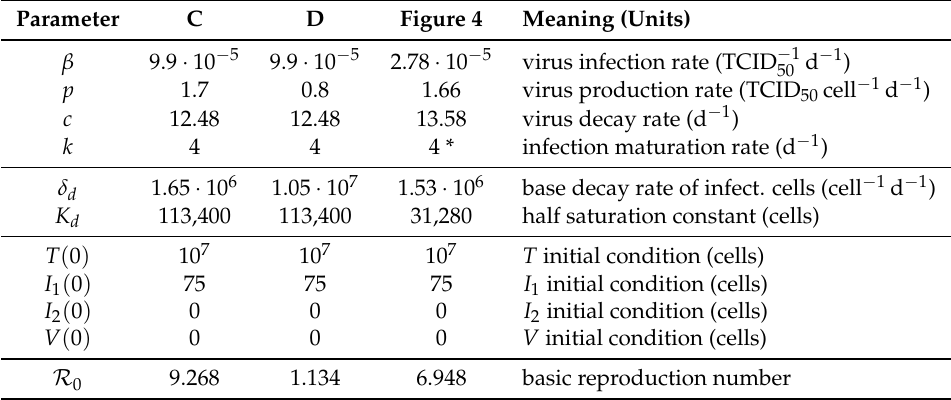
Table 2. Parameters of the target model (9) corresponding to data Figure 1C,D and data fit in Figure 4. Fixed parameters are denoted with